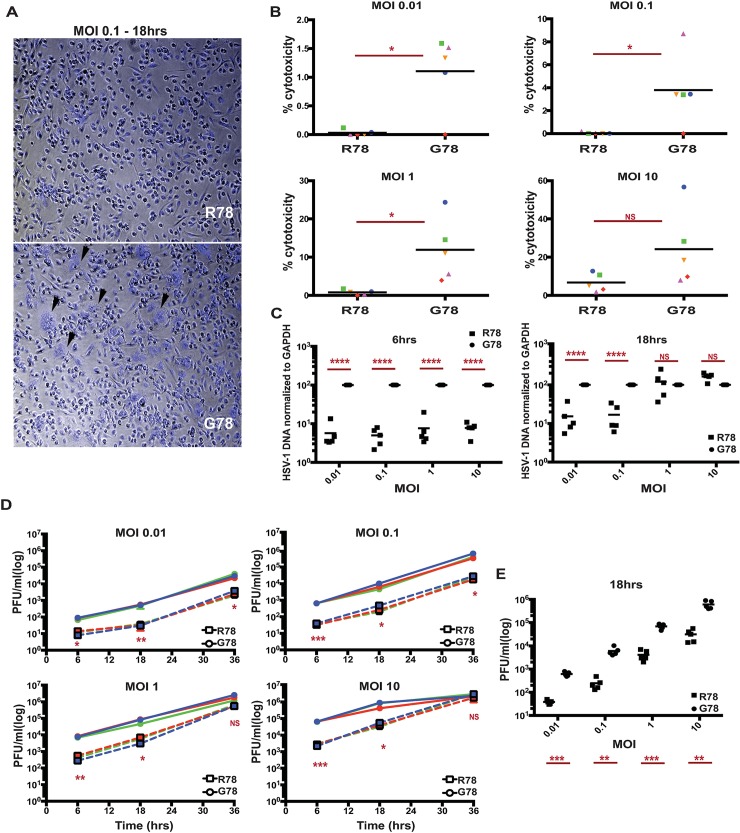
PILRA G78R reduces entry of HSV-1 into hMDMs.A) Representative images of hMDM, infected with HSV-1 for 18 hrs at MOI 0.1, were fixed and stained with DAPI. B) LDH cytotoxicity assay was performed on supernatants harvested from HSV-1-infected hMDMs after 18 hrs. Results are % cytotoxicity—amount of LDH in supernatant after infection compared to LDH released from cells completely lysed by lysis buffer, with completely lysed cells (maximum LDH release) considered as 100% for each donor. Each shape represents one donor pair. C) HSV-1 DNA was quantitated on DNA extracted from HSV-1-infected hMDMs after 6 and 18 hrs by qPCR. Results are % HSV-1 DNA normalized to GAPDH considering G78 donor as 100% for each donor pair. D,E) Viral titers in the supernatant of HSV-1-infected hMDMs were determined by plaque assay on Vero cells. Results are number of plaque forming units (pfu) per ml of supernatant collected from HSV-1-infected hMDMs. (D) 6, 18 and 36 hrs of infection (G78, solid lines; R78, dashed lines)(experiment 1) (E) 18 hrs of infection (data from two individual experiments). Statistical analysis is two-tailed paired (B,D,E) or unpaired (C) t-test performed on 3–5 genotyped individual donor pairs (p values <0.05 = *, <0.005 = **, <0.0005 = ***, <0.0001 = ****).